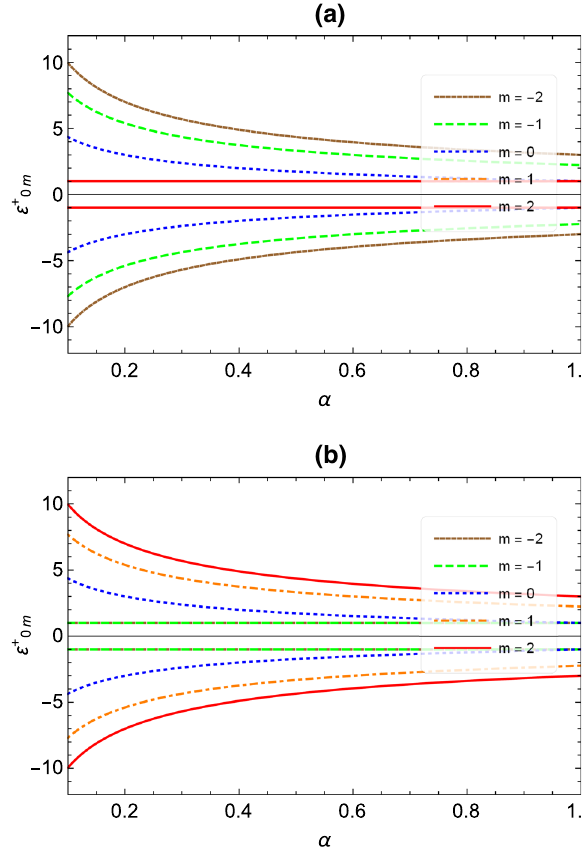
Fig. 6 Theenergy ¯ E − asafunctionoftheparameter α .Weuse M = 1 1 m and η L = 1. In a the plot for s = 1 and b for s = − 1. The states are more energetic near α = 0 . 1 and less energetic near α = 1 (cid:2)